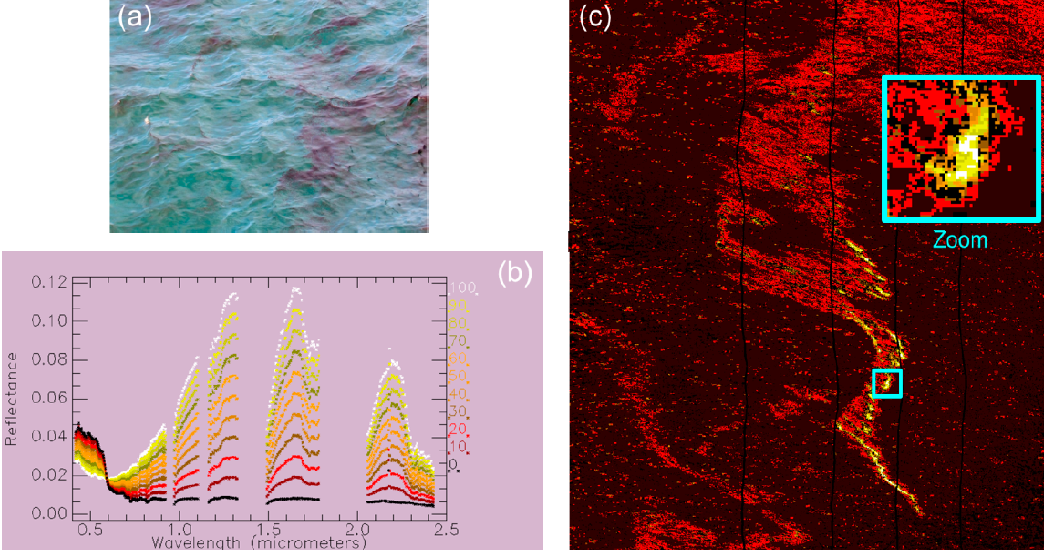
Figure 14. ( a ) Picture of the oil emulsion taken from the boat (note the coexistence of seawater and oil emulsion areas); ( b ) spectral library according to areal fraction in percentage; and ( c ) classification map of areal fraction. The color of pixels follows the color code of the spectral plots.